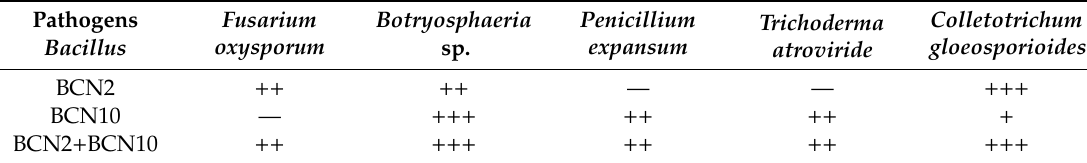
Table 1. Inhibition of volatile organic compounds from Bacillus methylotrophicus BCN2 and Bacillus thuringiensis BCN10 to mycelial growth of Fusarium oxysporum , Botryosphaeria sp., Trichoderma atroviride , Colletotrichum gloeosporioides, and Penicillium expansum at 28 °C for 3 days.